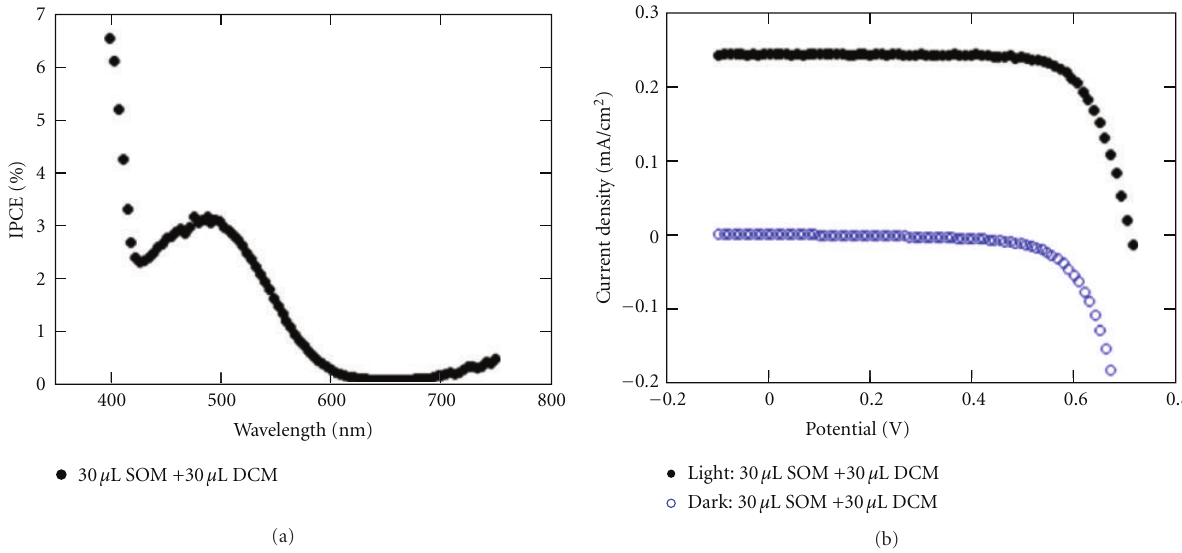
Figure 17: (a) The IPCE and (b) Photovoltaic behavior of a DCM 30-nanotube array device without a SQ-1 dye layer. J sc is 0.25 mA/cm 2 , V oc = 0.71 V, FF = 0.74, and η = 0.13%. Reprinted with permission from